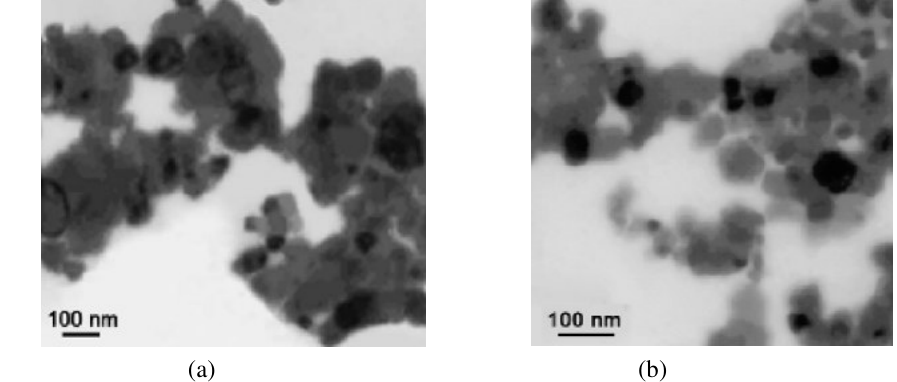
Figure 5. TEM photograph of (a) LiMn 2 O 4 (b) LiNd 0.3 Mn 1.7 O 4